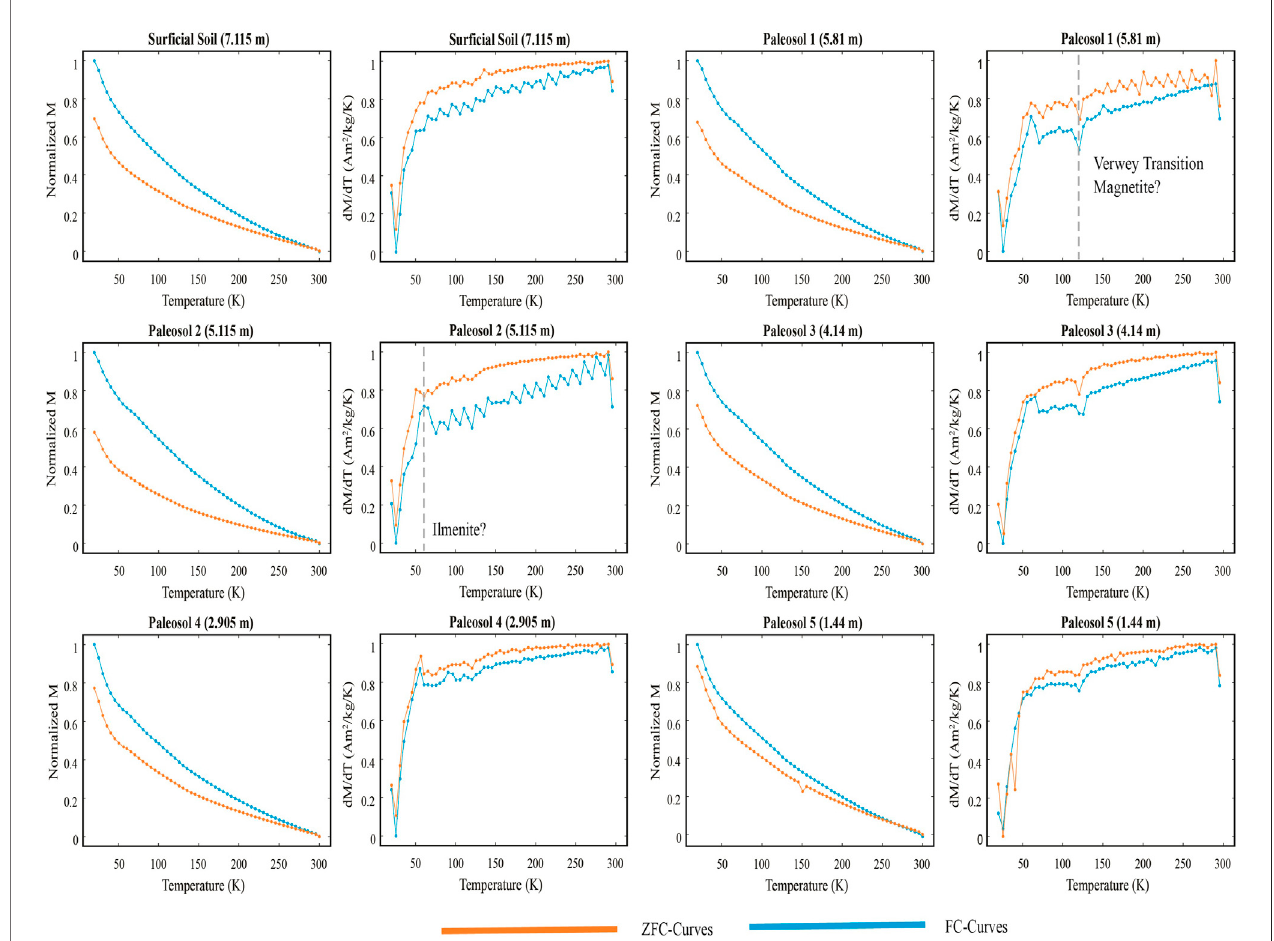
FIGURE8| ZFC(orange)andFC(blue)curvesforall fi vepaleosolsandtheSur fi cialSoil.DerivativesoftheFC/ZFCcurveswithrespecttotemperaturearedisplayed tothe leftofeach paleosol. Note thesubtle changeinslope at ∼ 120 K,most evident inPaleosols1,3, and 5.Thischange(represented asasharpdropinthederivatives) is interpreted to represent the Verwey transition of magnetite (Verwey, 1939).